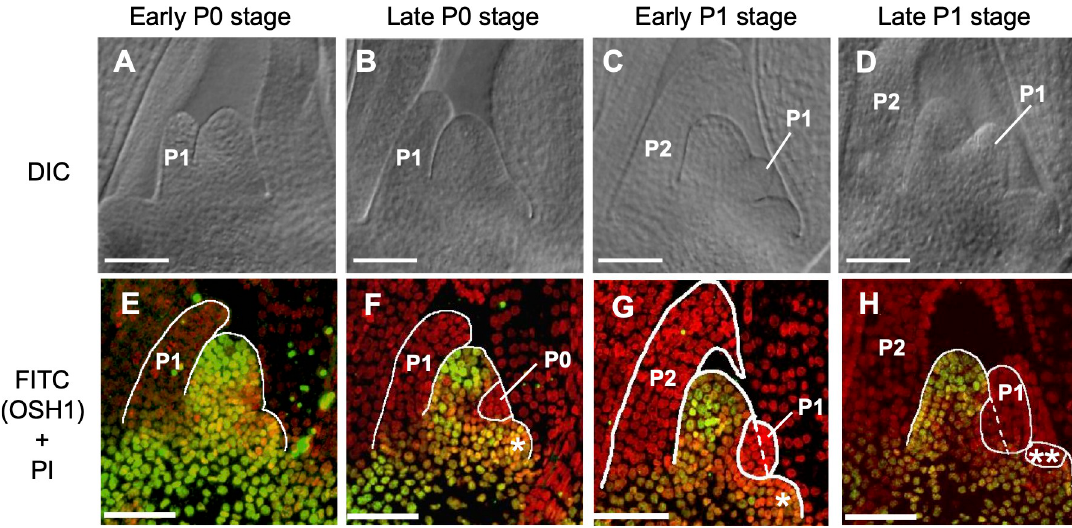
Fig 1. Dynamic transformation of morphology and OSH1 accumulation pattern in shoot apical meristem during a plastochron in rice. (A–D) Differential interference-contrast images of a SAM during a plastochron in wild type rice. (E–H) FITC (OSH1) and PI double staining of longitudinal sections of a SAM during a plastochron. Red signals indicate PI-stained nuclei. Green signals indicate OSH1 localization visualized by anti-OSH1 antibody and FITC. PI signals and OSH1 signals were captured independently and overlaid. P0, P1, and P2 indicate the stage of leaf development [29]. Labels at the top indicate the four stages within a plastochron that we defined. (A, E) Early P0 stage. (B, F) Late P0 stage. (C, G) Early P1 stage. (D, H) Late P1 stage. ( � ) Leaf base. ( �� ) Leaf edge. Dashed line indicates the border of meristem and bulge of P1. Scale bars: 50 μ